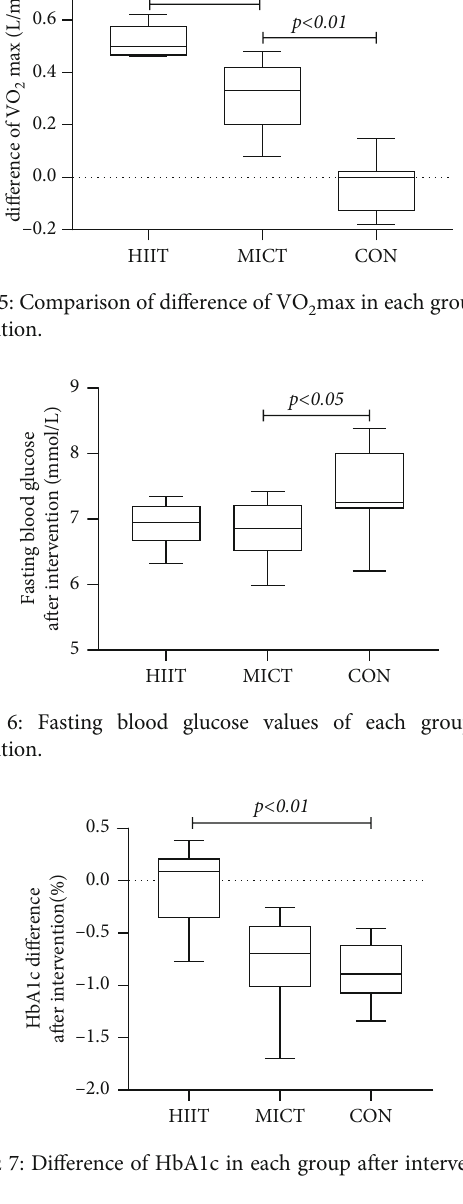
Figure 7: Di ff erence of HbA1c in each group after